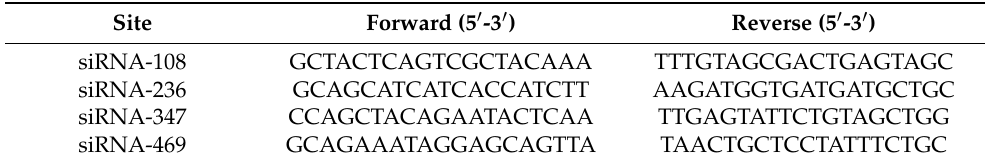
Table 2. Sequences of siRNA- slc38a9 for different sites.